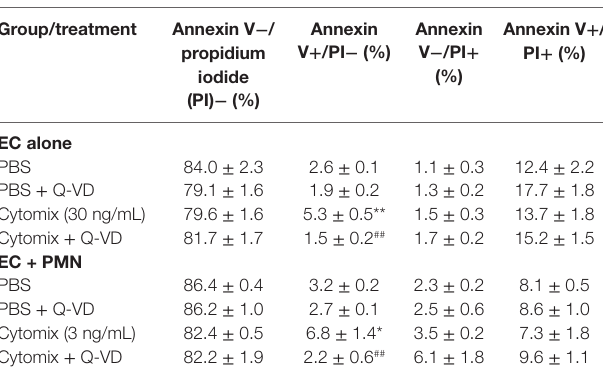
TaBle 1 | Effects of cytomix and Q-VD treatment on different types of cell death in isolated human PMVEC and in PMN–PMVEC cocultures.